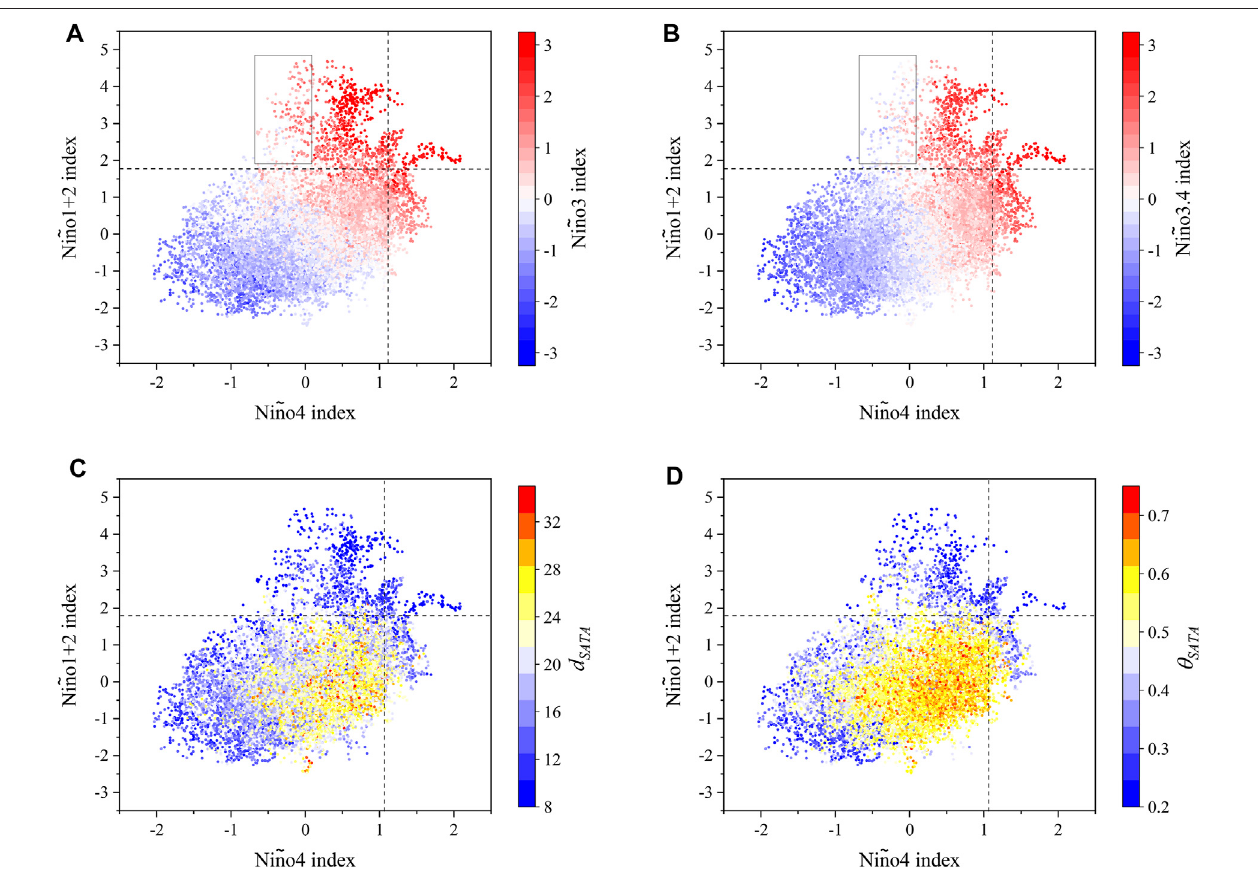
FIGURE2| Comparisons amongthefourNiñoindicesandthedynamicalpropertiesofSATA. (A) ScatterplotsofNiño1+2indexversusNiño4index,andthecolor map of the Niño3 index. The dash lines denote the 90% quantiles of the Niño1+2 and Niño4 indices, respectively. (B) Same as (A) , but the color map is for the Niño3.4 index. (C) Same as (A) , but the color map is for d SATA . (D) Same as (A) , but the color map is for θ SATA .